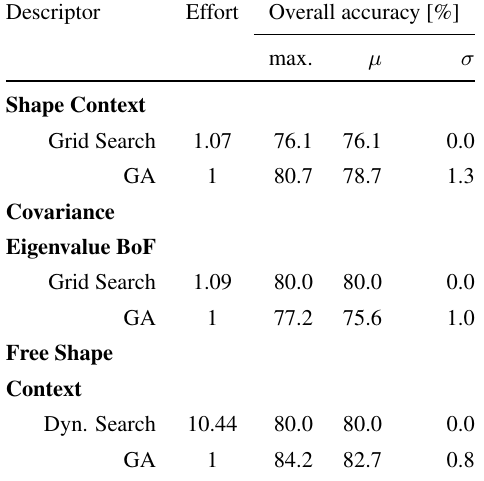
Table 1: Evaluation results for considered features w.r.t. clas- sification accuracy. Workload reflects the number of evaluated parameter sets (1 = number of evaluations in a single GA